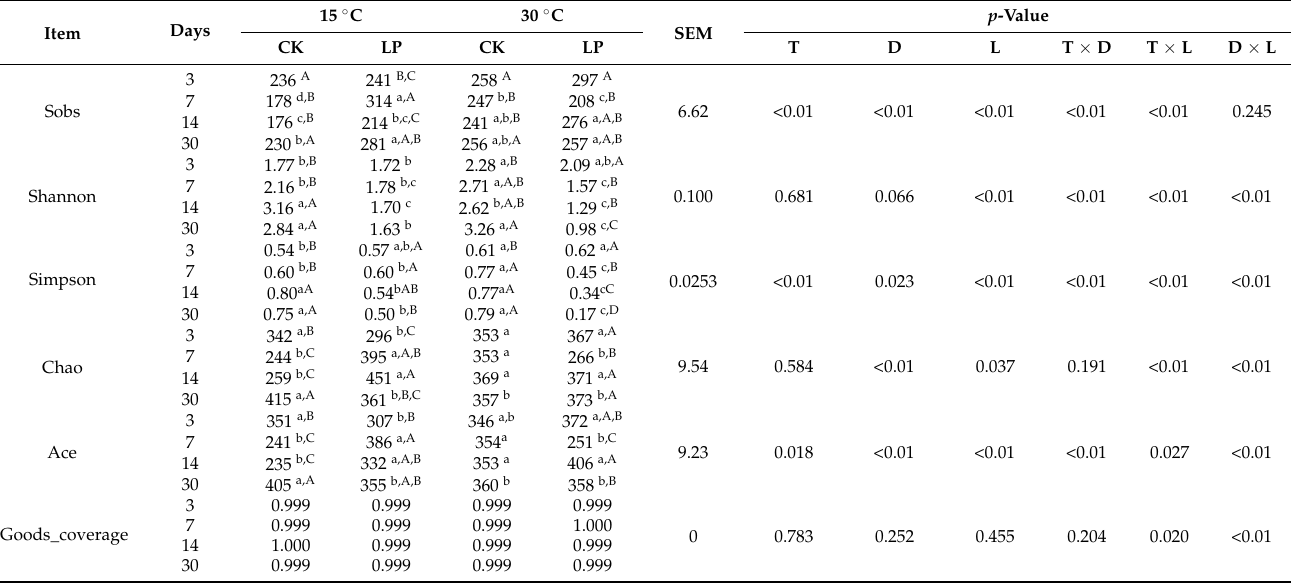
Table 3. Alpha diversity of bacterial community of B. papyrifera leaves silage ensiled with or without